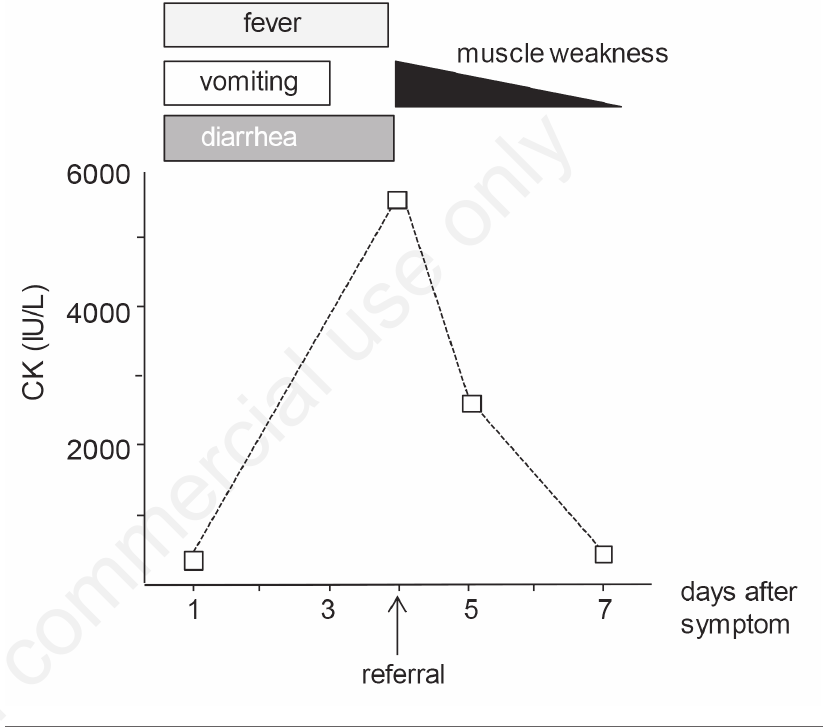
Figure 1. Clinical course and serum creatine phosphokinase activity of the patient. The patient was referred to our department on day 4 following 3 days of infusion for gastroen- teritis. While she did not have fever, vomiting and/or diarrhea on the day of referral, she was not able to stand or walk. However, she recovered within 4 days without any medica-